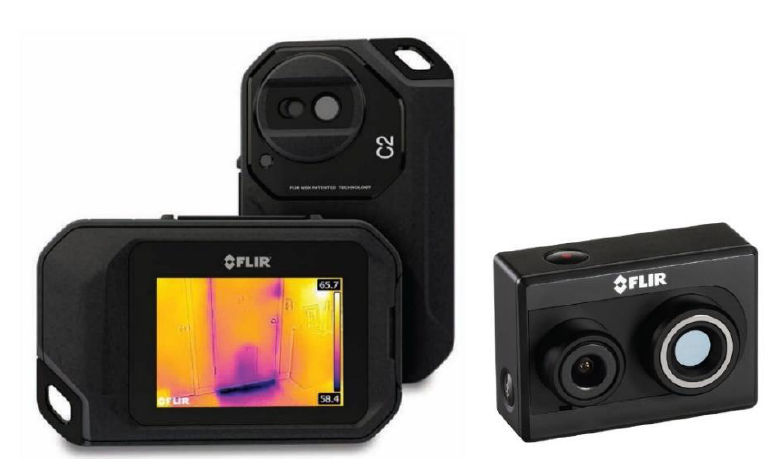
Figure 2. FLIR C2 (left) and FLIR Duo R (right) [47,48]. Pictures are not in scale.